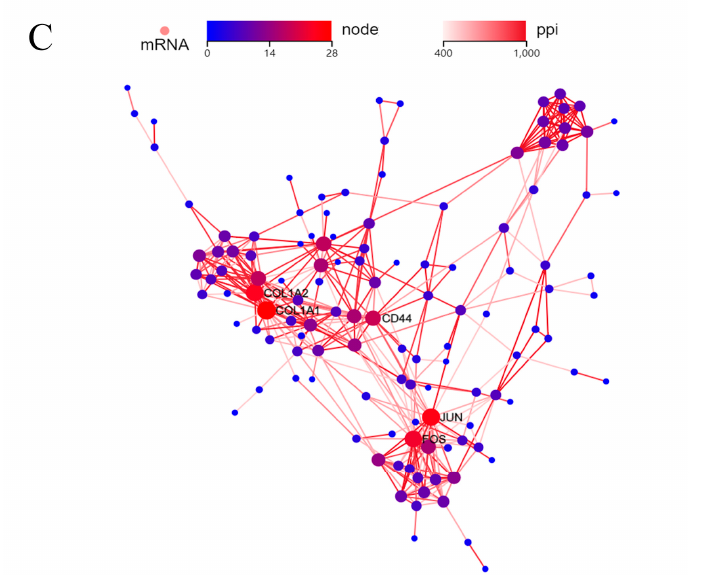
Figure 3. Expression of proteins in cryopreserved ovarian cells. ( A ) Top 5 proteins that were differentially expressed in cells of Group 1 (one-time cryopreservation) and Group 2 (two-time cryopreservation). ( B ) Top 5 proteins that were differentially expressed in cells of Group 3 (one-time cryopreservation and in vitro culture);.( C ) Top 5 proteins that were differentially expressed in cells of Group 4 (two-time cryopreservation and in vitro culture).